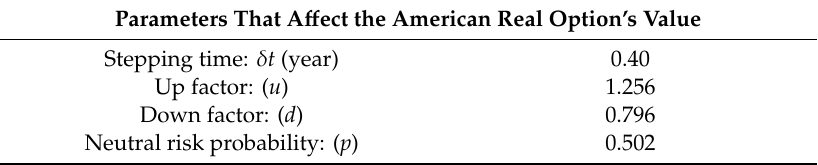
Table 6. Recombining binomial lattice parameters (Natura’s acquisition of The Body Shop). Parameters That A ff ect the American Real Option’s Value